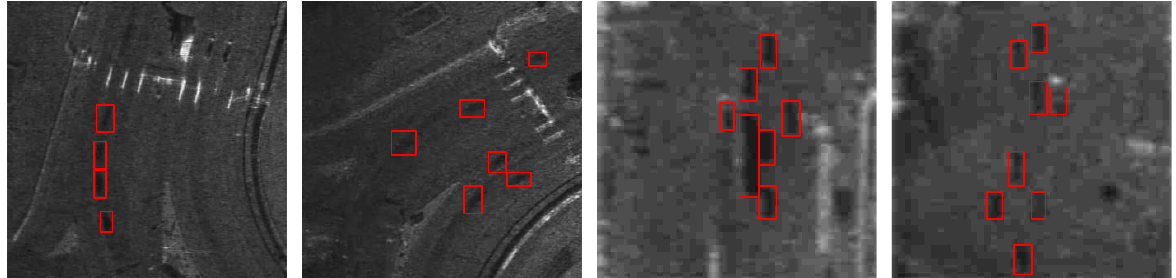
Figure 1. Four real scenes including multiple moving